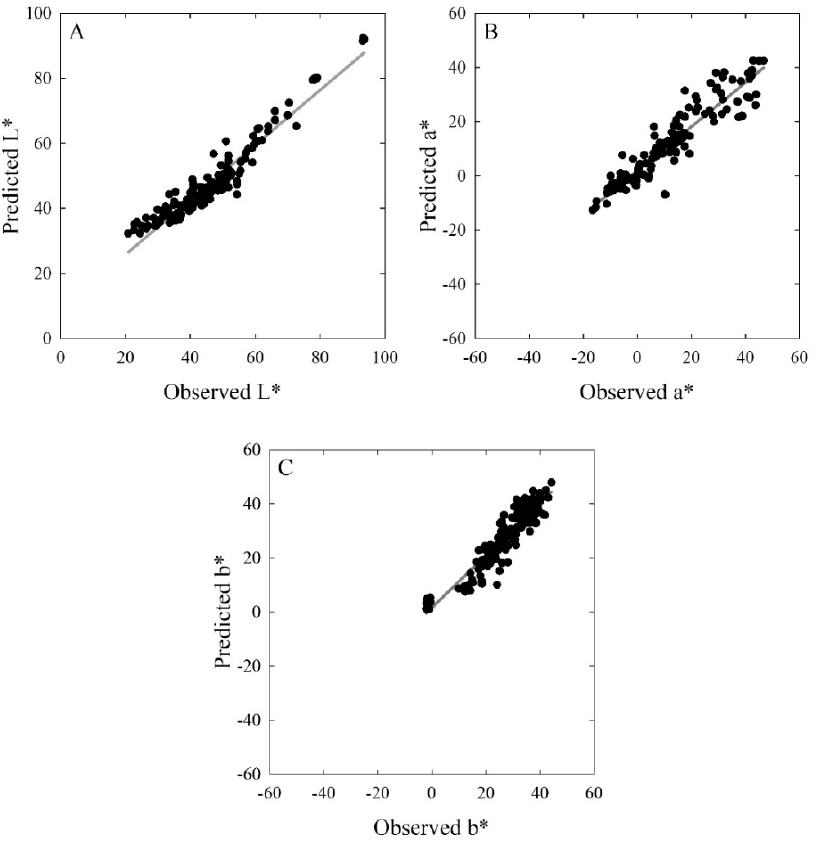
Figure 4. Scatter plots of validation datasets of colourimeter’s L* ( A ), a* ( B ) and b* ( C ) (predicted) against reference spectrophotometer’s L*, a* and b* (observed), respectively. Table 2. Lin’s concordance correlation coefficient ( r c ) with 95% confidence intervals (in brackets) and root mean square error ( RMSE ) reported for the validation models obtained with colourimeter’s L*, a* and b* (predicted variables) against spectrophotometer’s L*, a* and b* (observed